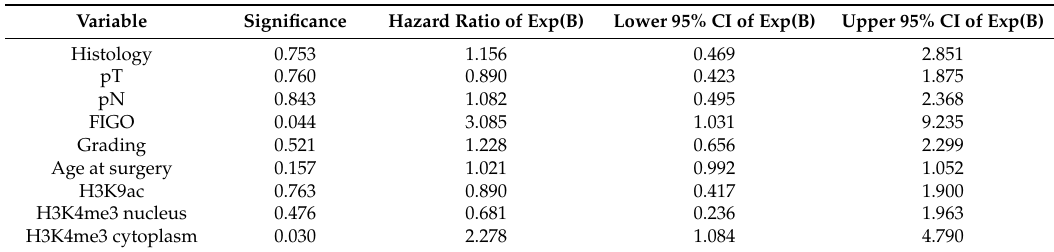
Table 4. Co12x regression of clinic pathological variables regarding progress-free